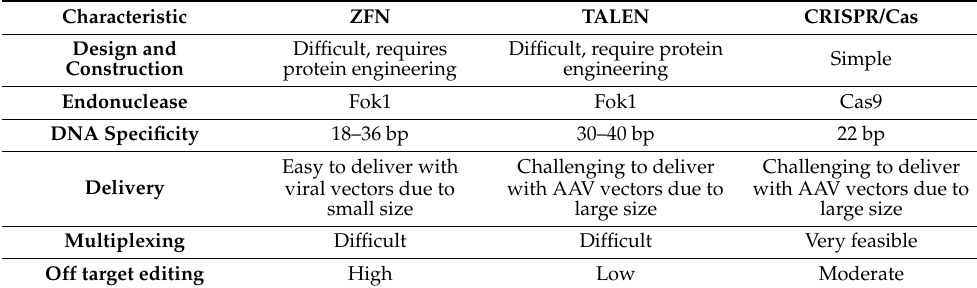
Table 2. Comparison of gene-editing tools (ZFN, TALEN and CRISPR/Cas). Characteristic ZFN TALEN CRISPR/Cas Design and Difficult, requires Difficult, require protein Construction protein engineering engineering Simple Endonuclease Cas9 DNA Specificity 18–36 bp 22 bp Easy to deliver with Challenging to deliver Challenging to deliver Delivery viral vectors due to with AAV vectors due to with AAV vectors due to small size large size large size Multiplexing Difficult Difficult Very feasible High